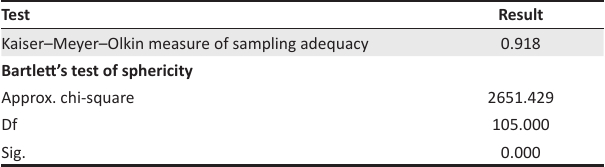
TABLE 3: Kaiser–Meyer–Olkin and Bartlett’s tests.